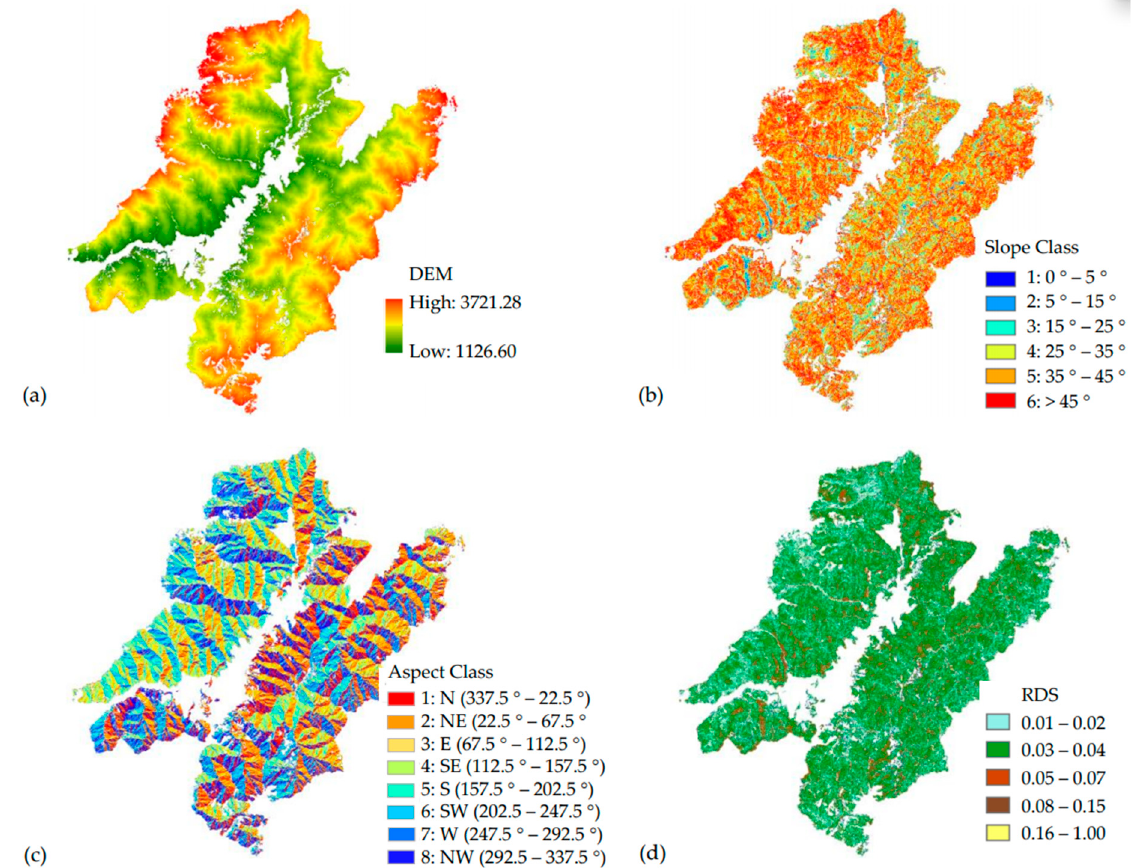
Figure 2. Topographical variables of the study site (( a ): DEM, ( b ): slope class, ( c ): aspect class, and ( d ): reciprocal of the slope degree).